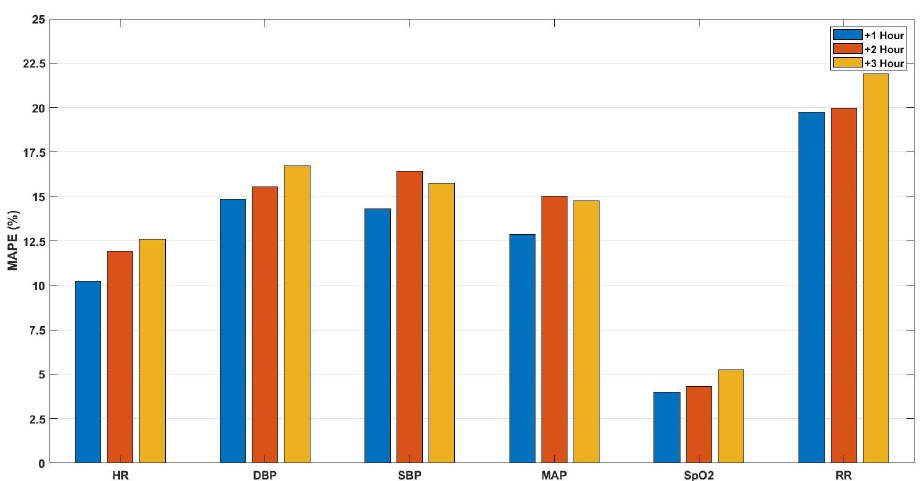
Figure 2. The mean absolute percentage error of the predictions for the upcoming three hours (+1, +2, +3 h) of the vital signs: heart rate (HR), diastolic (DBP), systolic (SBP), mean arterial blood pressure (MAP), oxygen saturation (SpO 2 ), and respiration rate (RR), respectively, based on the hourly to bi-hourly observation rate.